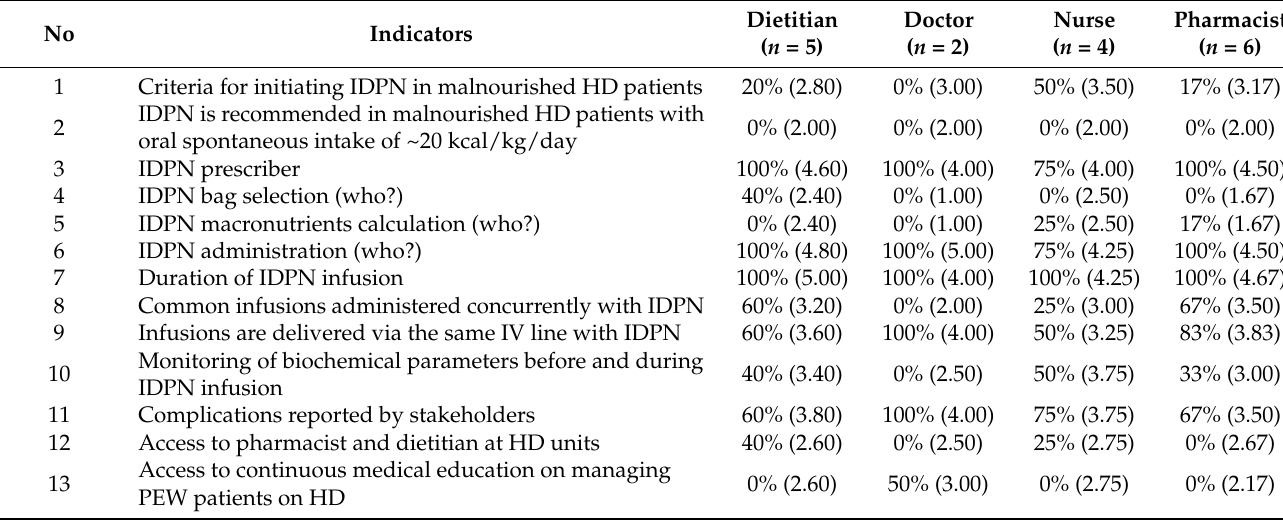
Table 3. Percentage and Mean Scores Rated by Individual Health Professional Group with Good Adherence to Practice